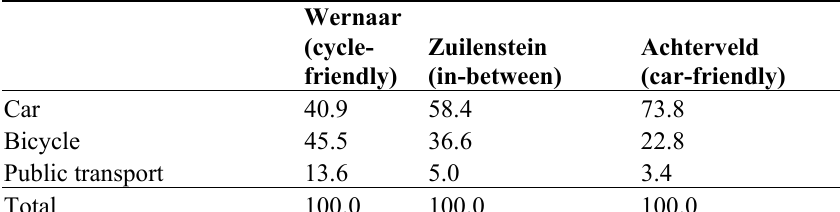
Table 1. Preferences for modes (%) according to